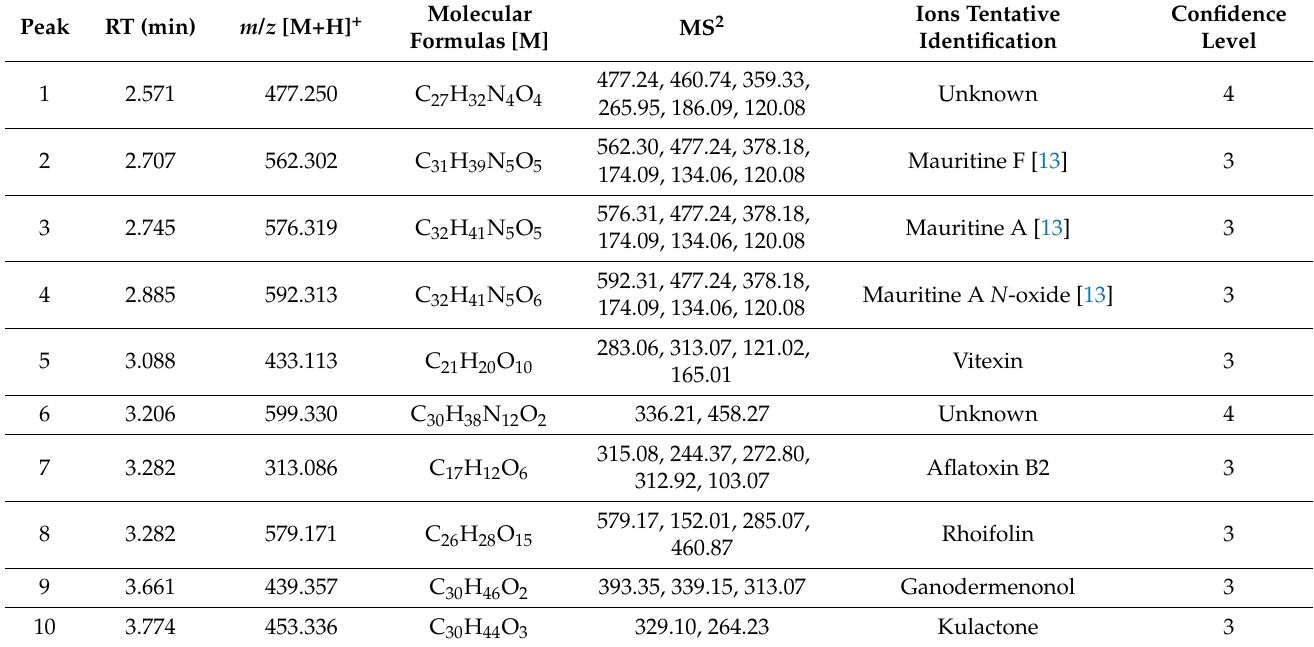
Table 1. Tentative identification of compounds from crude extract of E . exsul by LC − ESI-MS/MS in the positive ion mode.